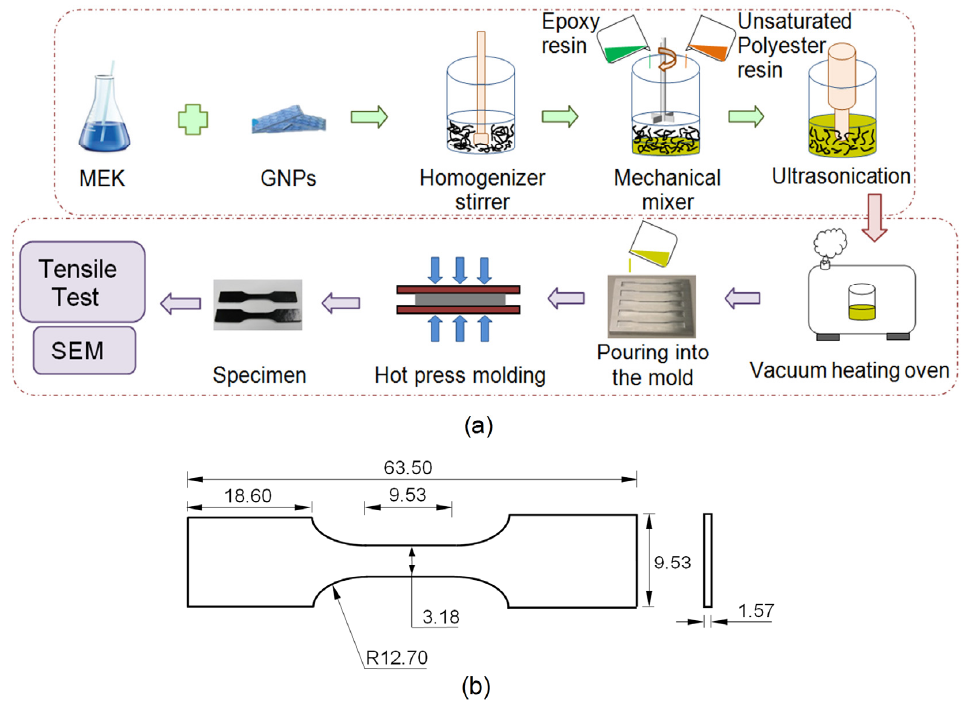
Figure 2. ( a ) Schematic showing the manufacturing process of the nanocomposite; ( b ) dimensions of specimen in ASTM standard Type V (mm).